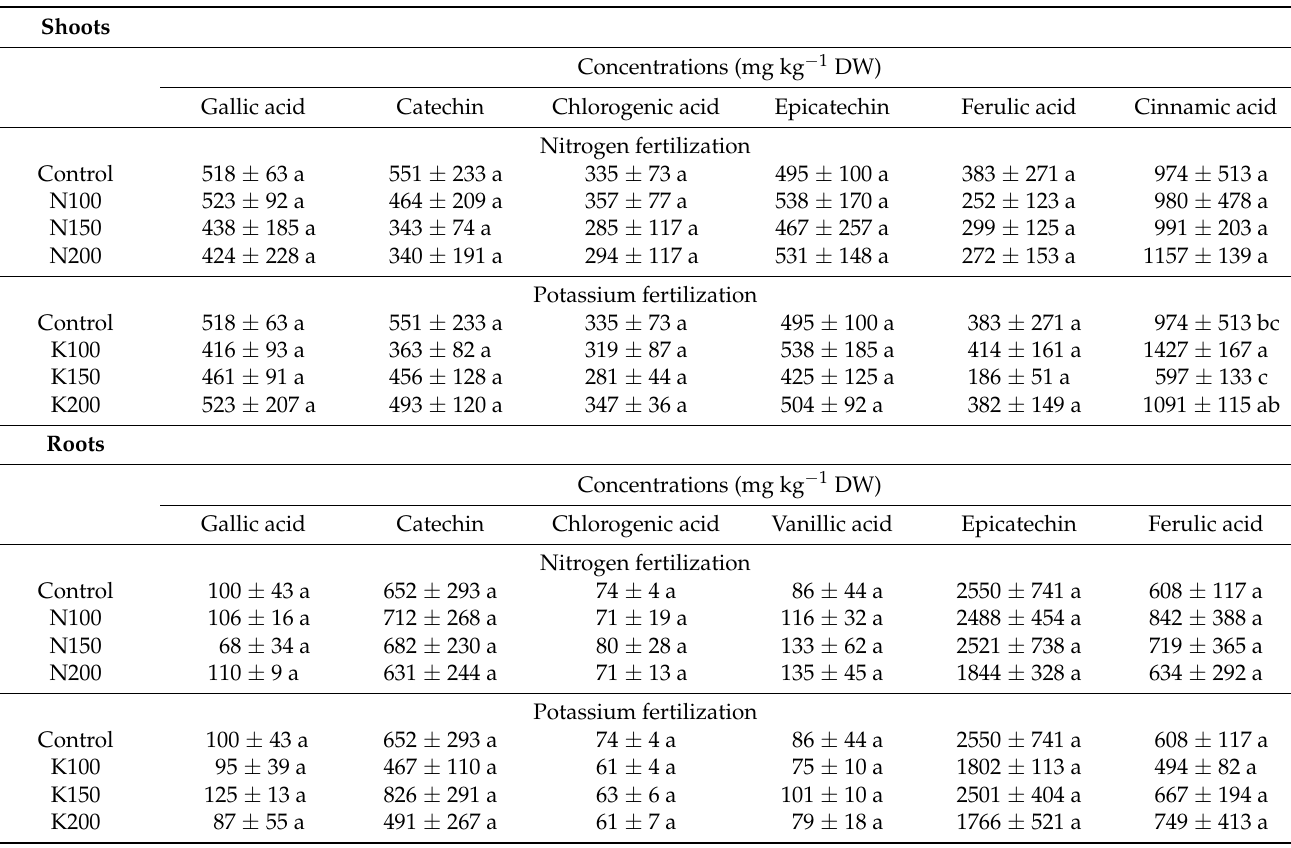
Values are mean ± standard deviation (n = 4). Averages followed by the different letters in the same column of the same fertilizer treatment indicate significant difference between treatments ( p < 0.05, LSD multiple range